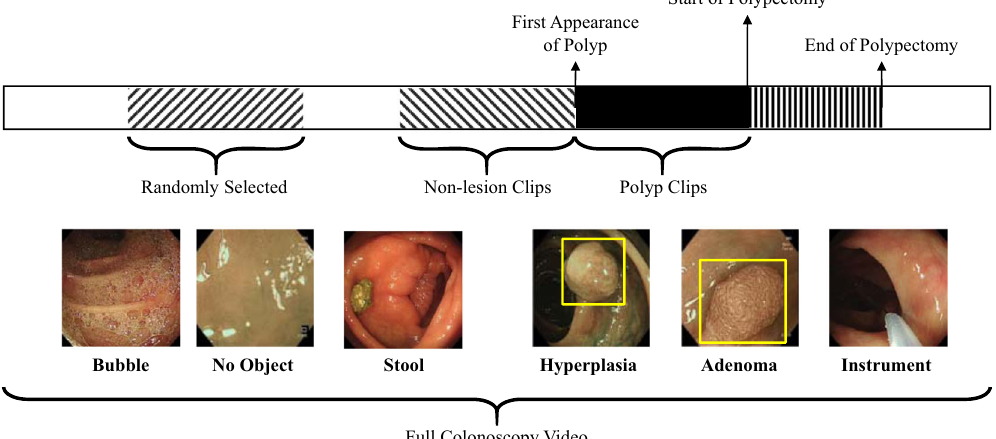
Fig. 5 An illustration of video clips and types of images that were found in a full colonoscopy video. Three timepoints were marked for each full colonoscopy video: (1) the fi rst appearance of the polyp, (2) the start of the biopsy/polypectomy procedure, con fi rmed by the fi rst appearance of an endoscopic tool; and (3) the end of its biopsy/polypectomy procedure. Nil were recorded when no polyp was found in a colonoscopy video. The colonoscopy images were screened by an earlier version of AI-doscopist. All localised objects were classi fi ed into 13 categories, namely “ Adenomatous Polyp ” , “ Hyperplastic Polyp ” , “ Other Polyp ” , “ Bleeding ” , “ Lumen ” , “ IC Valve ” , “ Normal Colon Structure ” , “ Instrument ” , “ Stool ” , “ Bubble ” , “ Artefact ” , “ Inside Colon Background ” , and “ Outside Colon Background ”